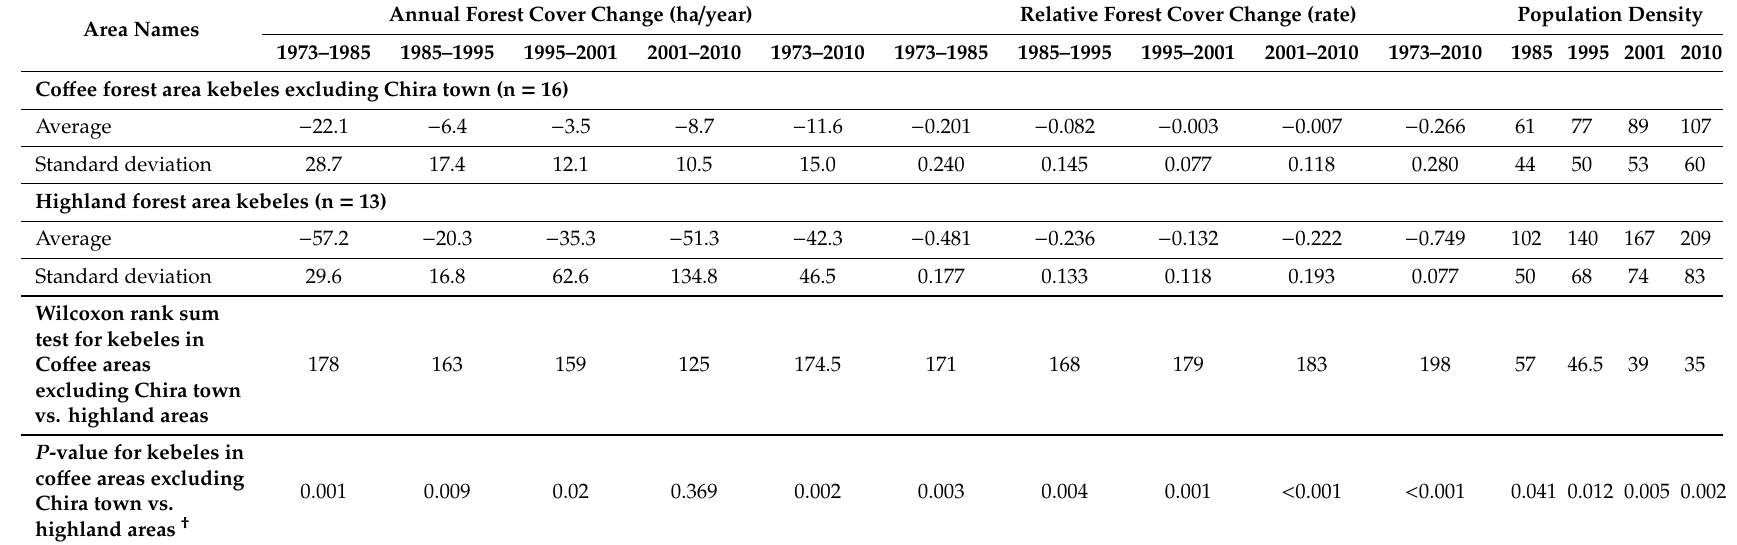
Table 2. Di ff erences in forest area change per year, relative rate of forest cover change, and population density between kebeles located in co ff ee and highland forest areas of